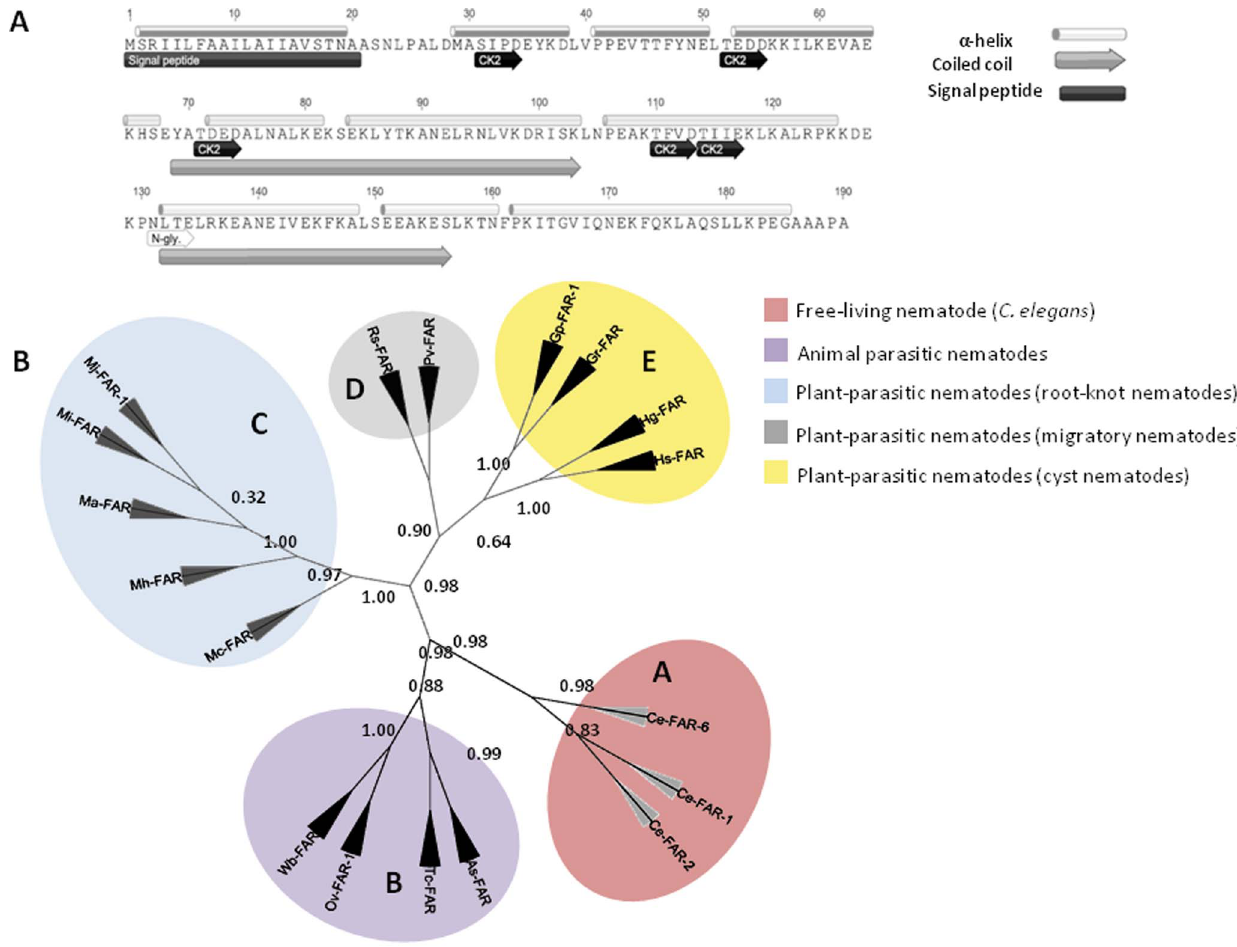
Figure 1. Mj-FAR-1 characterization. A. Primary and secondary structure analysis of predicted Mj-FAR-1. A putative hydrophobic leader/signal peptide, as predicted by the SignalP program is shown at the N terminus along with a cleavage site between two alanine residues at position 20–21. Consensus N -linked glycosylation site (N-gly) and the consensus casein kinase II phosphorylation sites (CK2) are indicated. Secondary structure analysis through Jpred predicts a predominantly alpha-helical conformation (gray cylinder) with coiled-coil structures (gray arrow) as shown. B. Phylogenetic tree of Mj-FAR-1 with other nematode FAR proteins. The tree was constructed with FAR protein sequences of: C. elegans (Ce-FAR-1, Ce- FAR-2 and Ce-FAR-6) belong to group A, human parasitic nematodes O. volvulus (Ov-FAR-1) and W. bancrofti (Wb-FAR), animal parasitic nematodes A. suum (As-FAR) and T. canis (Tc-FAR), and plant-parasitic nematodes, M. javanica (Mj-FAR-1), M. incognita (Mi-FAR), M. arenaria (Ma-FAR), M. hapla (Mh- FAR) and M. chitwoodi (Mc-FAR), cyst forming nematodes G. pallida (Gp-FAR-1), G. rostochiensis (Gr-FAR), H. glycines (Hg-FAR), H. schachtii (Hs-FAR) and migratory endoparasites P. vulnus (Pv-FAR) and R. similis (Rs-FAR). Bootstrap values are shown at each node. 1,000 bootstrap replicates were obtained, with nearly the same results, and only a single tree retrieved from the phylogenetic relationship analysis is shown. Five clusters in the phylogenetic tree have been arbitrarily assigned the names A, B, C, D and E.